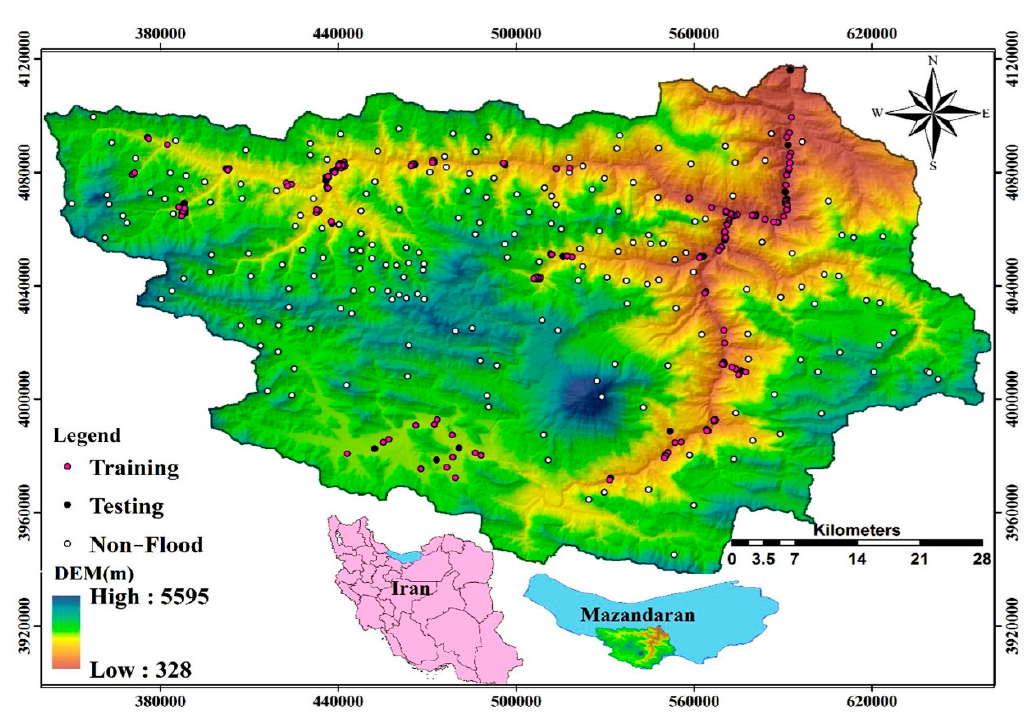
Figure 1. Flood locations mapped on a hill-shaded map of the Haraz Catchment, Iran.